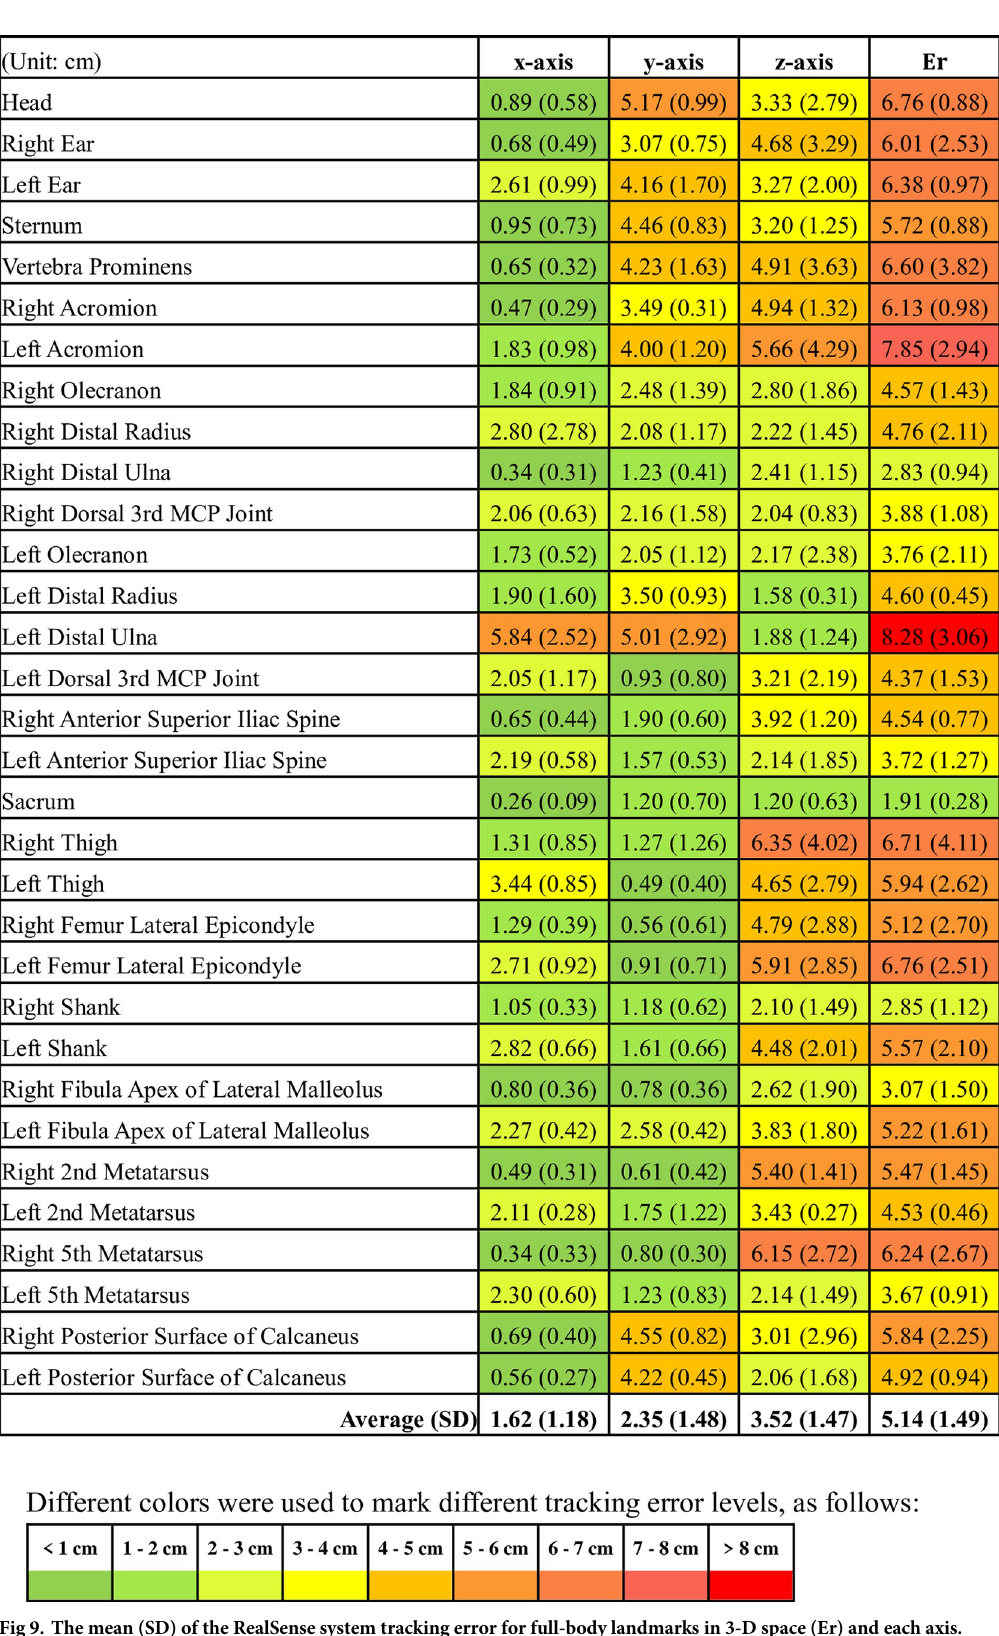
Fig 9. The mean (SD) of the RealSense system tracking error for full-body landmarks in 3-D space (Er) and each axis. https://doi.org/10.1371/journal.pone.0254814.g009 PLOS ONE | https://doi.org/10.1371/journal.pone.0254814 July 21,